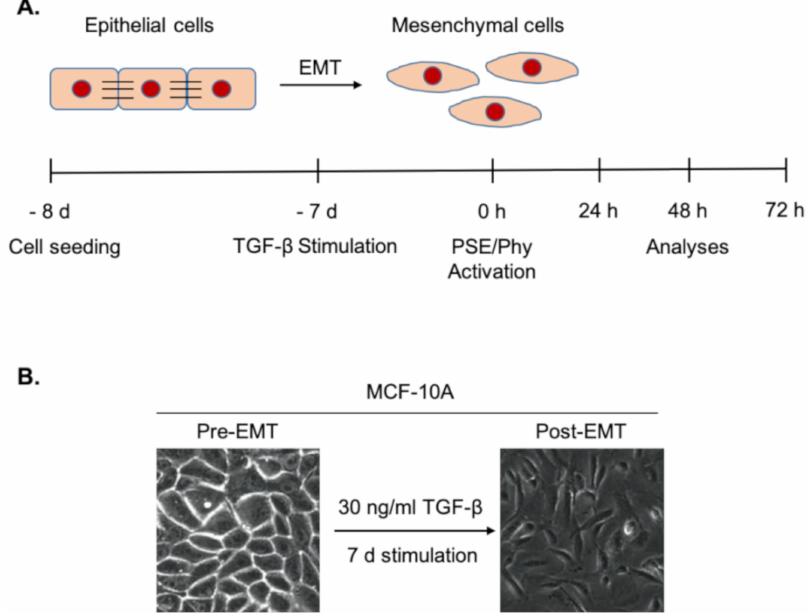
Figure 1. ( A ) Experimental design for study epithelial to mesenchymal transition (EMT) in MCF-10A and BJ-5ta cells and ( B ) EMT morphological changes after 7 days (d) of TGF- β stimulation. Original magnification, 40x. Copyright Petrova